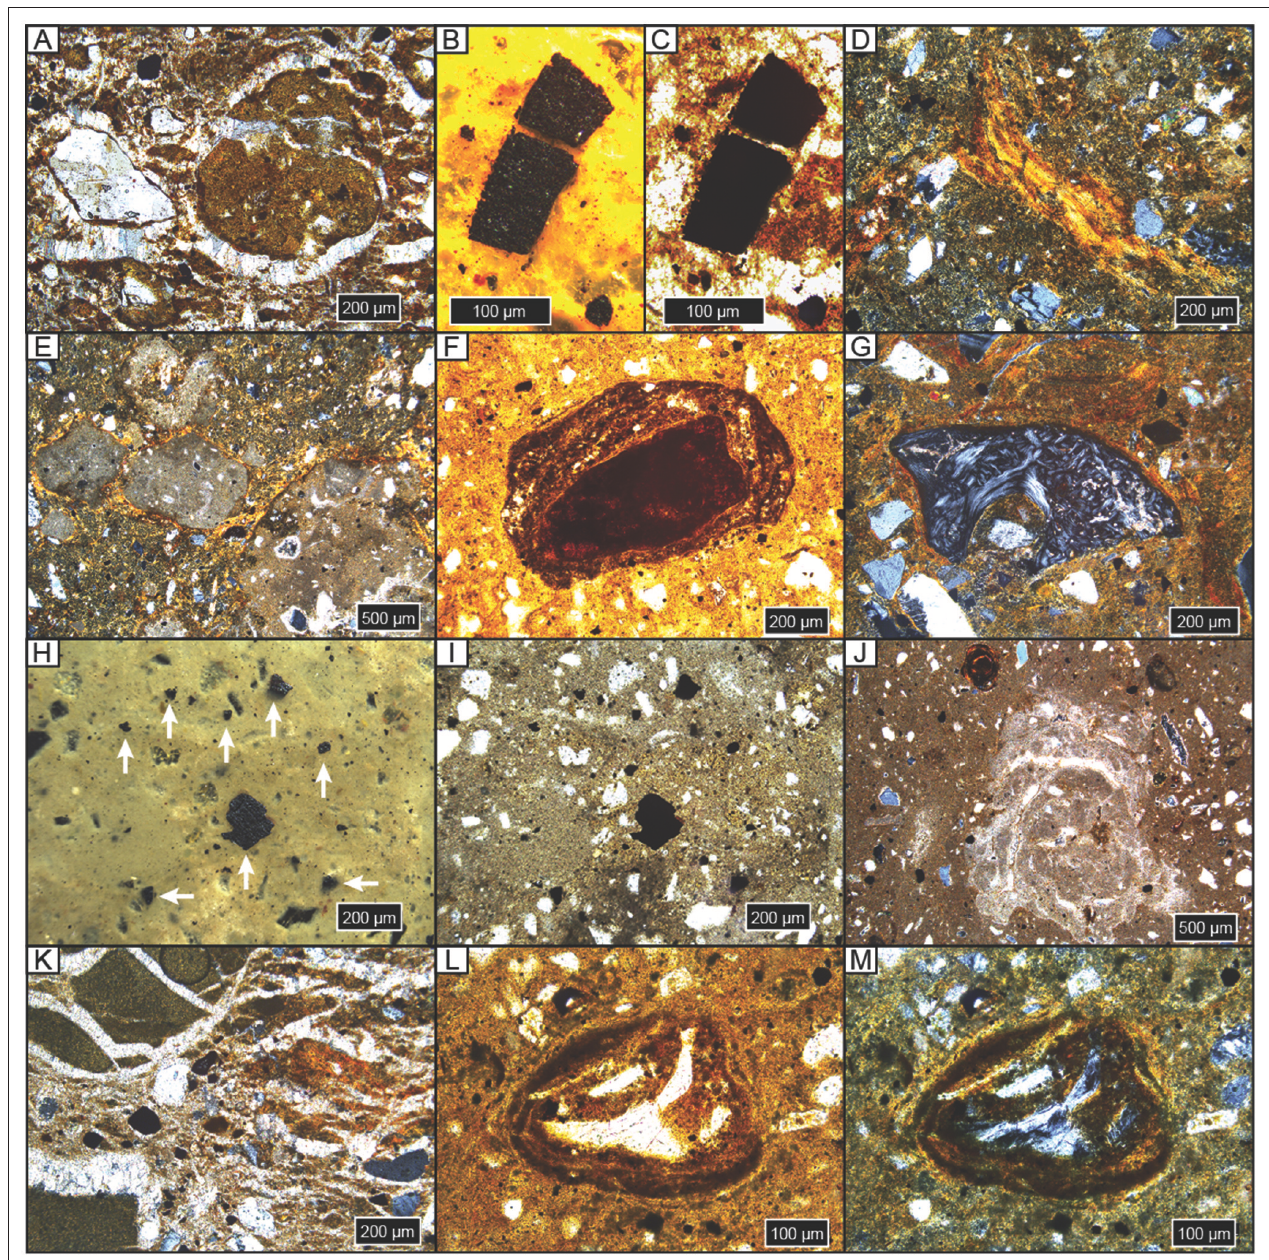
FIGURE 5 | Photomicrographs of representative features. All samples are upright and in cross-polarized light unless noted. (A) Diagenetic sparite overgrowths on detrital quartz grain, on and in a micritic carbonate nodule, and throughout matrix; NG15-B, BC. (B,C) Microcharcoal grain in reflected light (B) and plane-polarized light (ppl) (C) ; NG15-B, BC. (D) Argillan and granostriated clay fabric on quartz and weathered orthoclase detrital grains; NG15-B, 2Btk. (E) Micritic carbonate nodules with sparite filling septarian cracks with pedogenic clay bridges (granostriated fabric); NG15-B, 2Btk. (F) Fe concretion nucleated on weathered detrital grain; note clay coatings within and on concretion, and clay-rich matrix; ppl, NG15-A, 2Btk. (G) Granostriated clay fabric on bone chip and detrital grains; NG15-A, 2Btk. (H,I) Microcharcoal grains in reflected light (H, white arrows) and ppl (I); NG15-B, 2BC. (J) Microspar carbonate concretion with sparite filling septarian cracks. Thin clay coats line septarian walls. Note Fe concretion and sparite overgrowths on detrital grains; NG15-A, 3Bw. (K) Displacive sparite around and within clay clasts (left) and orange pedogenic clay (right), on detrital grains, and through matrix; NG15-B, 3C. (K,L) Bone chip encased in Fe/clay concretion, ppl (L) and xpl (M) ; NG15-B, 4Bw.